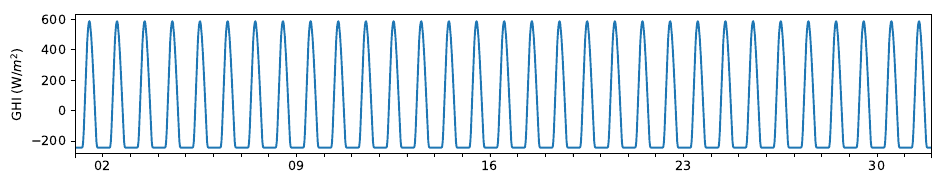
Figure 7. Seasonal component of GHI for December 2019.